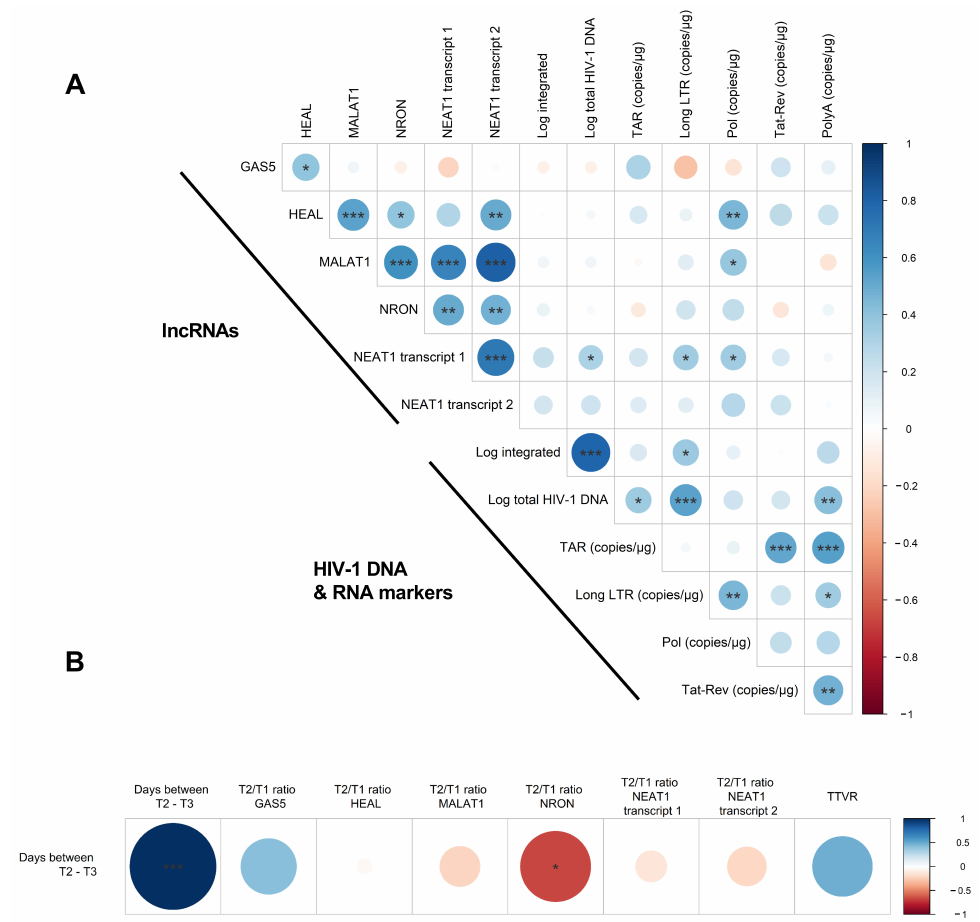
Figure 3. Correlation between lncRNA expression and HIV-1 markers. ( A ) Correlation plot indicating the correlation between lncRNA expression and HIV-1 viral DNA and RNA markers in participants undergoing ATI. Spearman correlations were calculated at all timepoints and included all participants. ( B ) Spearman correlation between lncRNA fold change expression (between T2 and T1) and the days from T2 to viral rebound. Positive and negative correlations are depicted in blue and red, respectively. Significant correlations are indicated with asterisks ( p < 0.05 *, p < 0.01 ** and p < 0.001